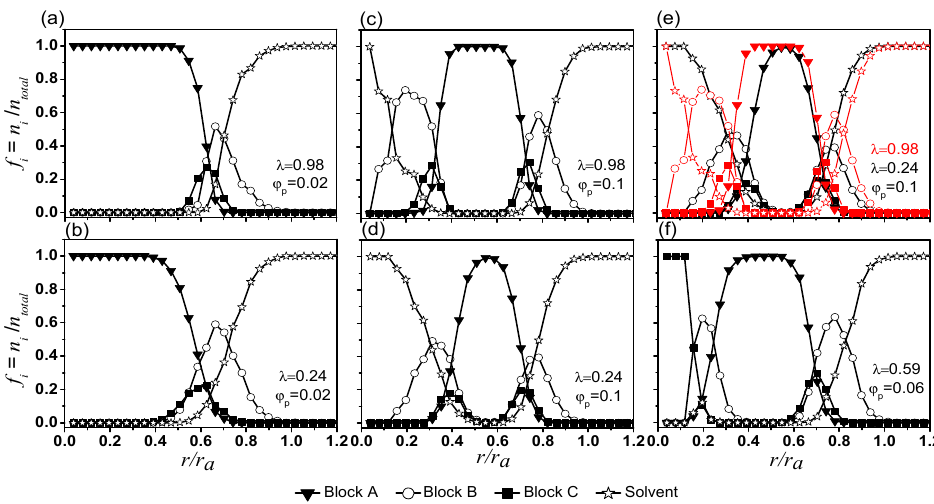
Figure 4. Composition profiles of aggregates (including skins and hydrated layers) formed under various conditions. Note the horizontal axis is the distance r from the center of mass of the aggregate normalized by the radius of the aggregate r a . The vertical axis is the number fraction of bead i , f i , in a particular r / r a and is the ratio of numbers of bead i to the total numbers of beads situated at a distance r away from the centre of mass.